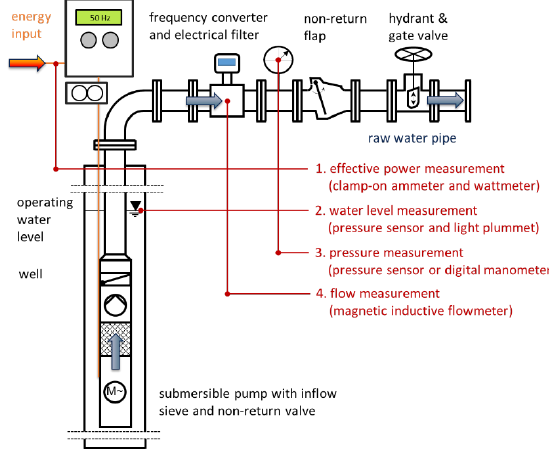
Figure 2. Measurement concept for data acquisition.